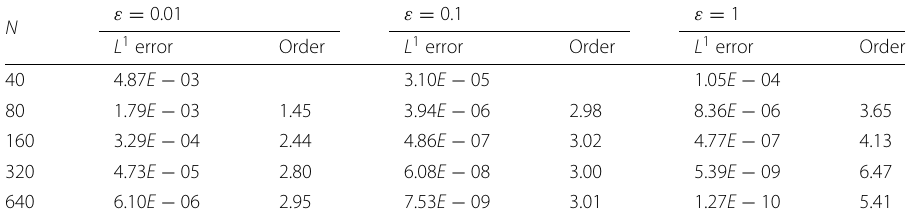
Table 4 Example 1. L 1 errors and numerical orders of temporal accuracy obtained with the SA IMEX-ARS3 WCNS at t =